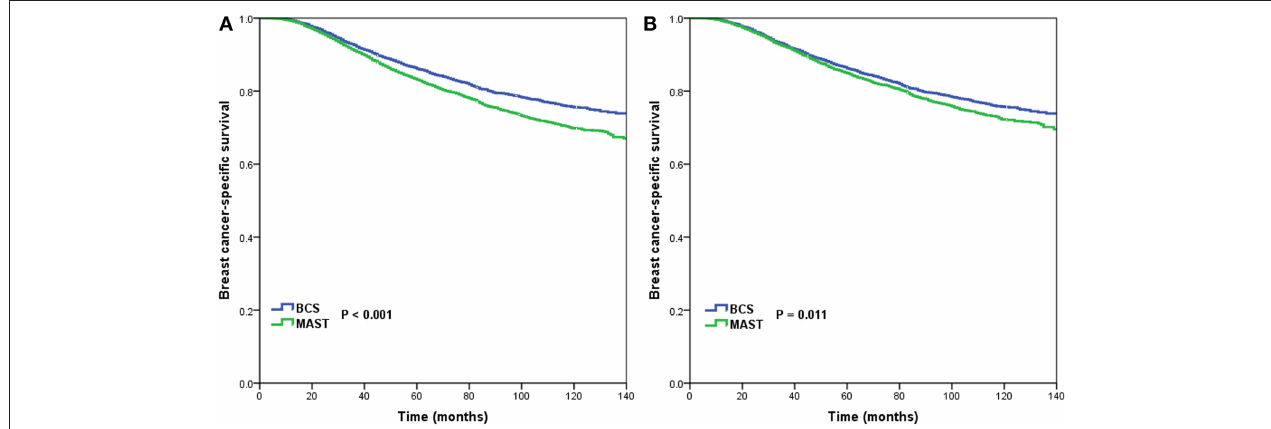
FIGURE 3 | Breast cancer-specific survival after breast-conserving surgery and mastectomy before (A) and after (B) propensity score matching.